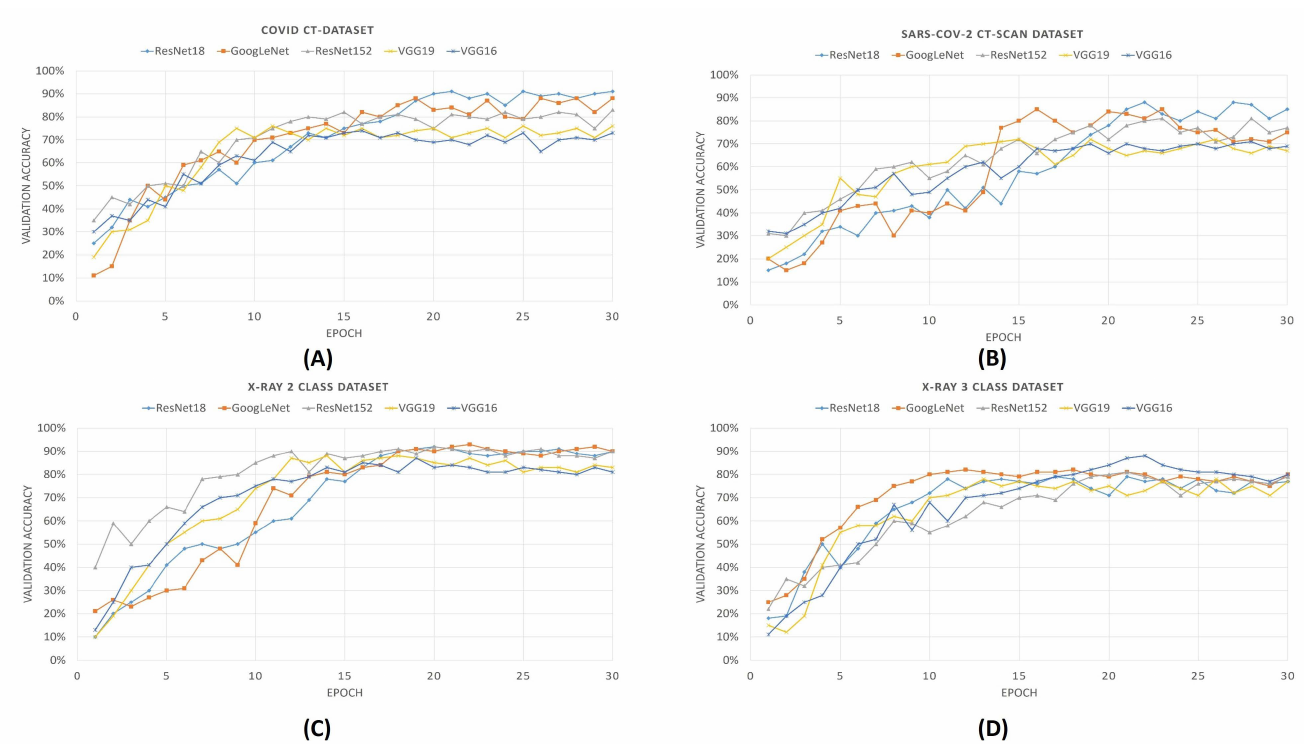
Figure 8. Validation accuracy plots of different pre-trained CNNs for all previously mentioned COVID-19 datasets. In the figure from ( A – D ) denotes the validation accuracy plots of COVID CT-Dataset, SARS-COV-2 CT-Scan Dataset, 2 calss and 3 class X-Ray